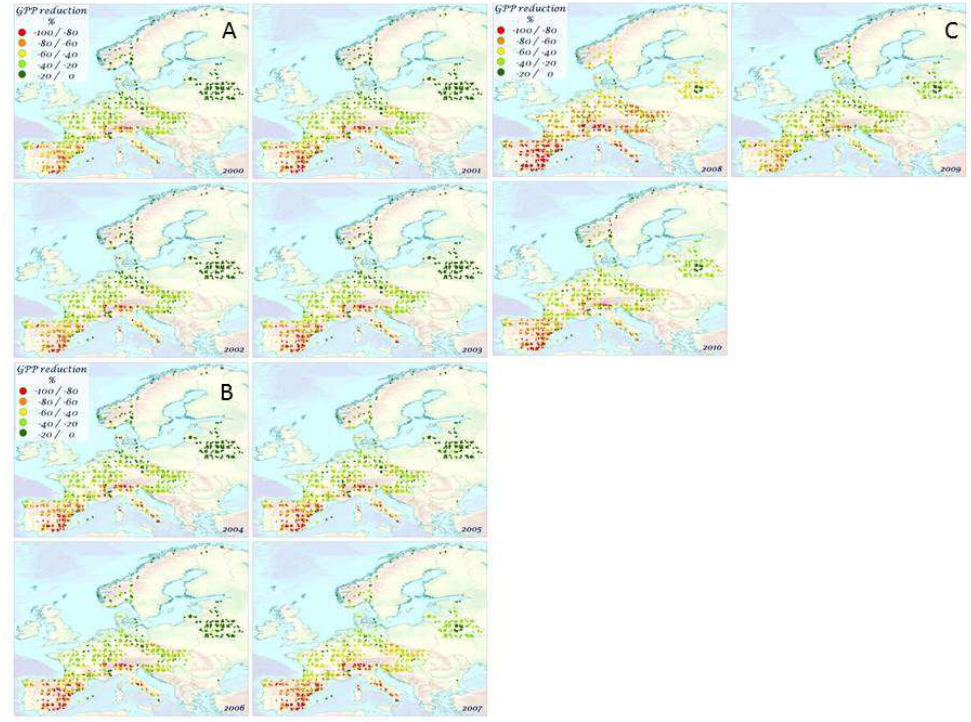
Figure 4. The percentage change of gross primary production (GPP) due to mTVWI, a proxy of soil water availability, over the time period 2000–2010.